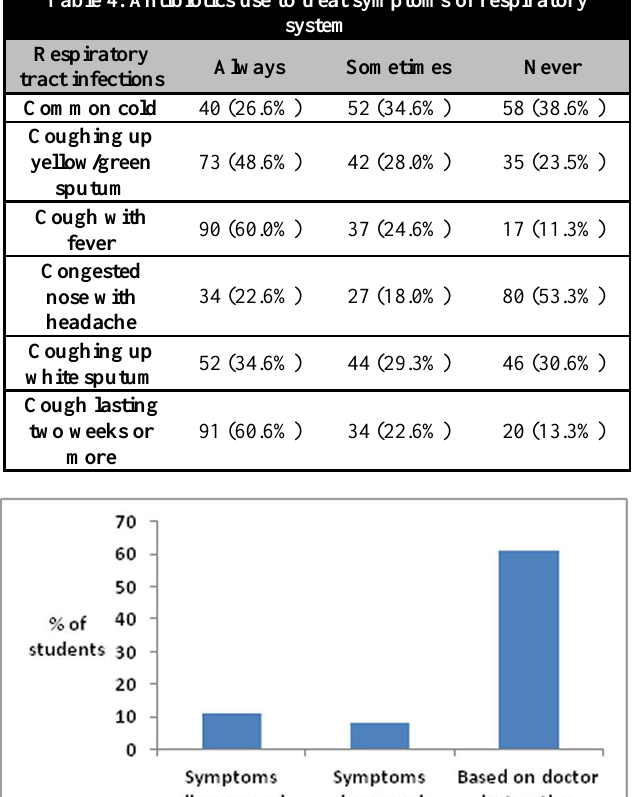
Table 4. Antibiotics use to treat symptoms of respiratory